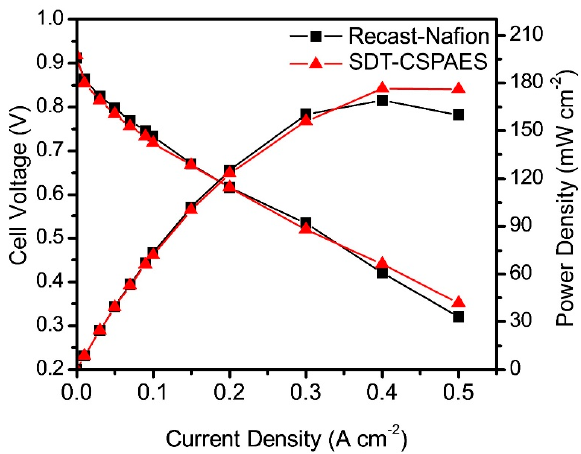
Figure 7. Cell performance of the MEAs made from recast-Nafion and SDT-CSPAES membrane at 120 °C under 40% RH with H 2 /air